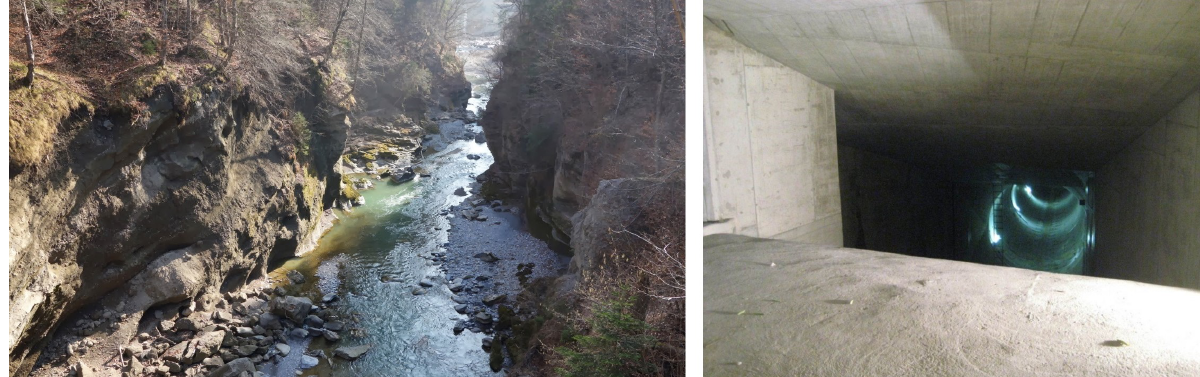
Figure 1. The Kander canyon today (left) with the flood relief gallery (right) in the City of Thun [2].